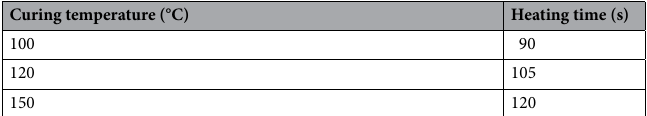
Curing temperature